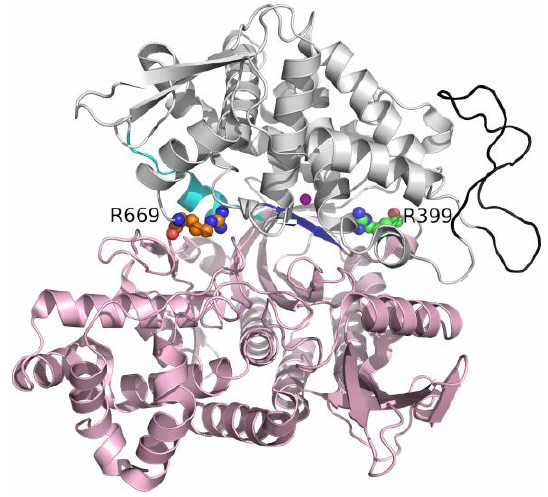
Figure 1. Location of the mutated arginine residues in the unbound enzyme structure from the PDB with code 5EGY. The lower protein domain residues (1–336, 375–420, and 669–726) are colored light pink, and the upper domain residues (337–374 and 421–668) are in gray. The flexible loop (residues 463–489) is colored black. The hinge (residues 409–420) involved in the conformational change of the protein is cyan, and the β -strand to which the ligand binds is colored blue. The zinc ion is colored magenta. Arginines 669 and 399 are in orange and green, with N and O atoms in red and blue.